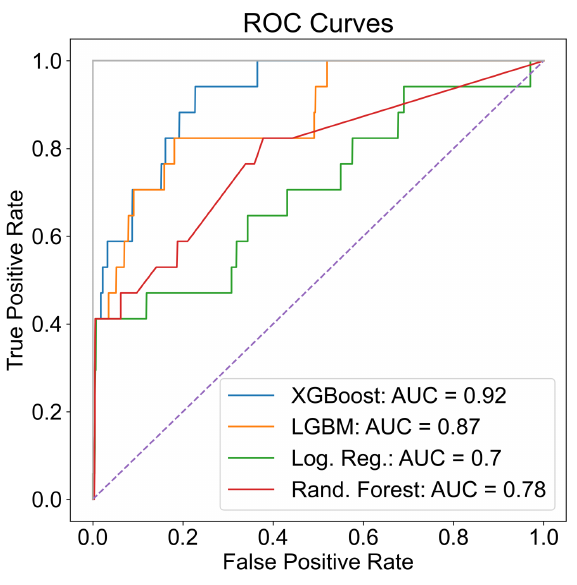
Figure 12. Performance of different machine learning models to identify students that experienced attrition in intermediate or advanced